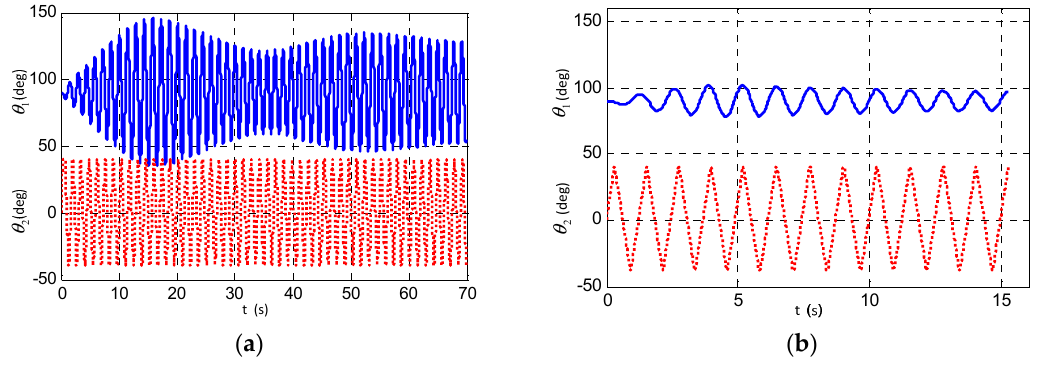
Figure 5. A simulation of the two-link model with ( a ) open-loop and ( b ) closed-loop control methods. The closed-loop strategy is developed to compensate for the drawbacks of the open-loop